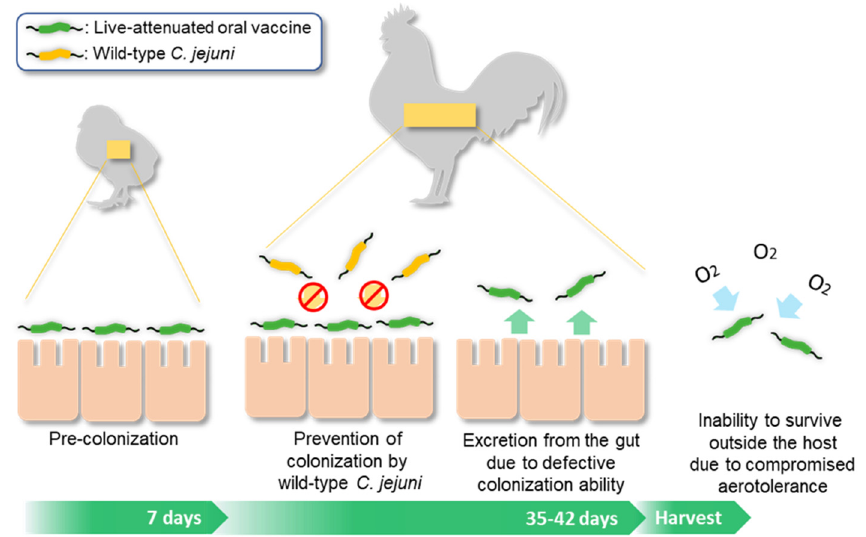
Figure 4. Rationale for how the Δ ahpC mutant works as a live-attenuated oral